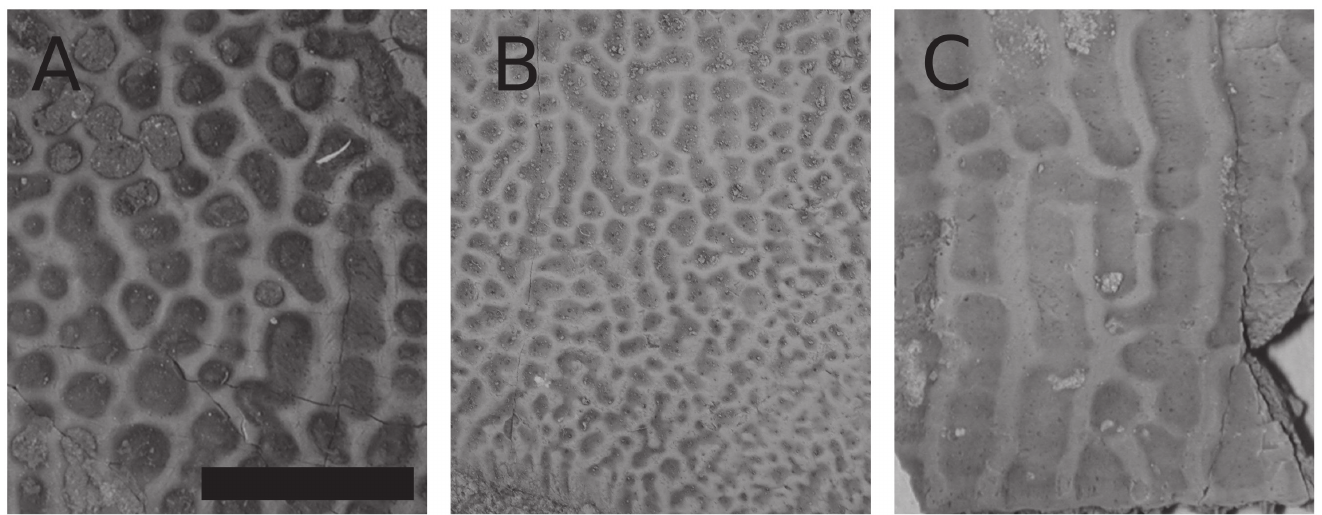
Figure 2. Costal sculpturing among Late Cretaceous trionychid turtles. Lateral edge of costal to the right for each image. A, TMP 1986.036.0302, an isolated costal from cf. Axestemys splendida from the Dinosaur Park Formation of Alberta. B, RBCM EH2004.012.1353. C, TMP 1986.009.0081, an isolated costal from Aspideretoides foveatus from the Dinosaur Park Formation of Alberta. All images at same magnification. Scale bar equals 1